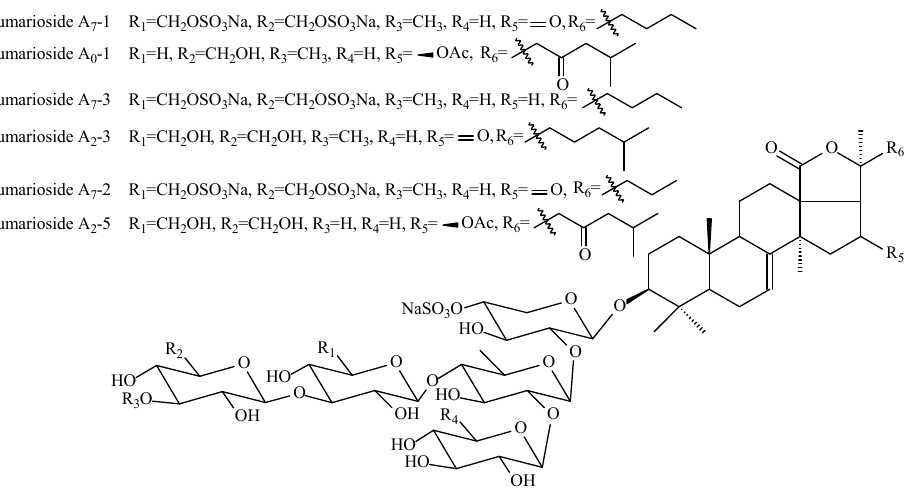
Figure 2. Structure of triterpene glycosides from the supercritical extract of C . frondosa japonica . Total compounds chromatogram of detected triterpene glycosides in negative ion mode shown in